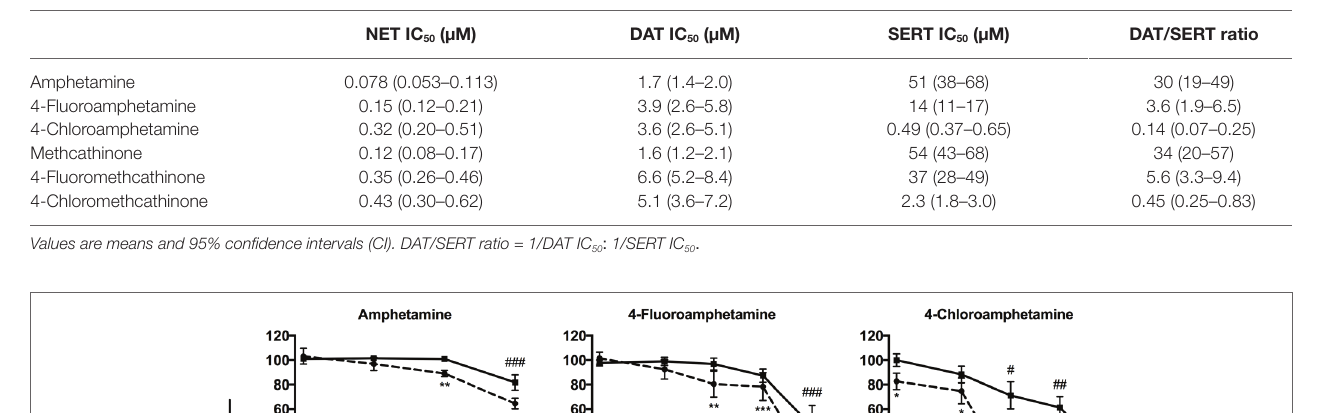
TABLE 1 | Monoamine uptake inhibition.